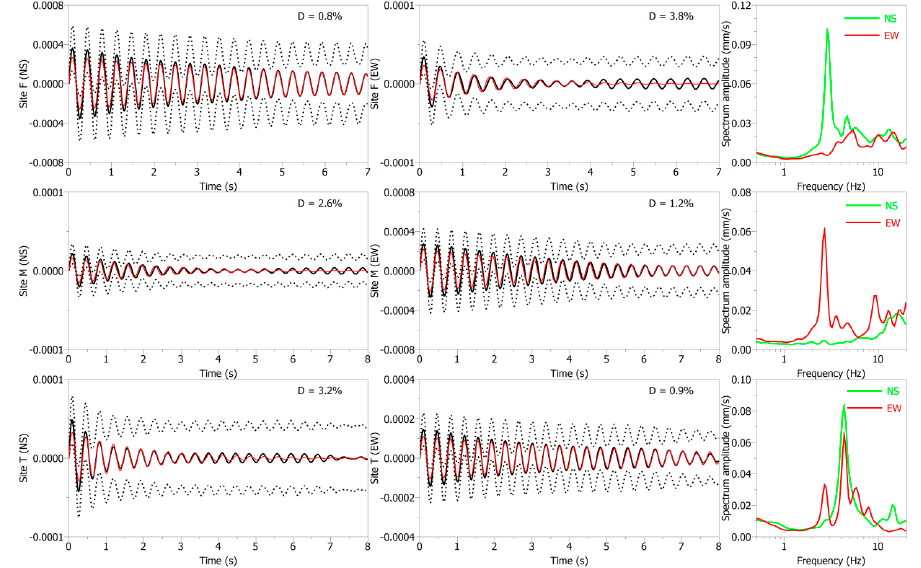
Figure 9. Examples of damping curves obtained using the random decrement method (RDM) and corresponding Fourier spectra (FFT) for selected sites. The continuous black line corresponds to the mean of the random decrement, the dashed lines correspond to the standard deviation, and the solid red line corresponds to the fitted exponentially decreasing function.